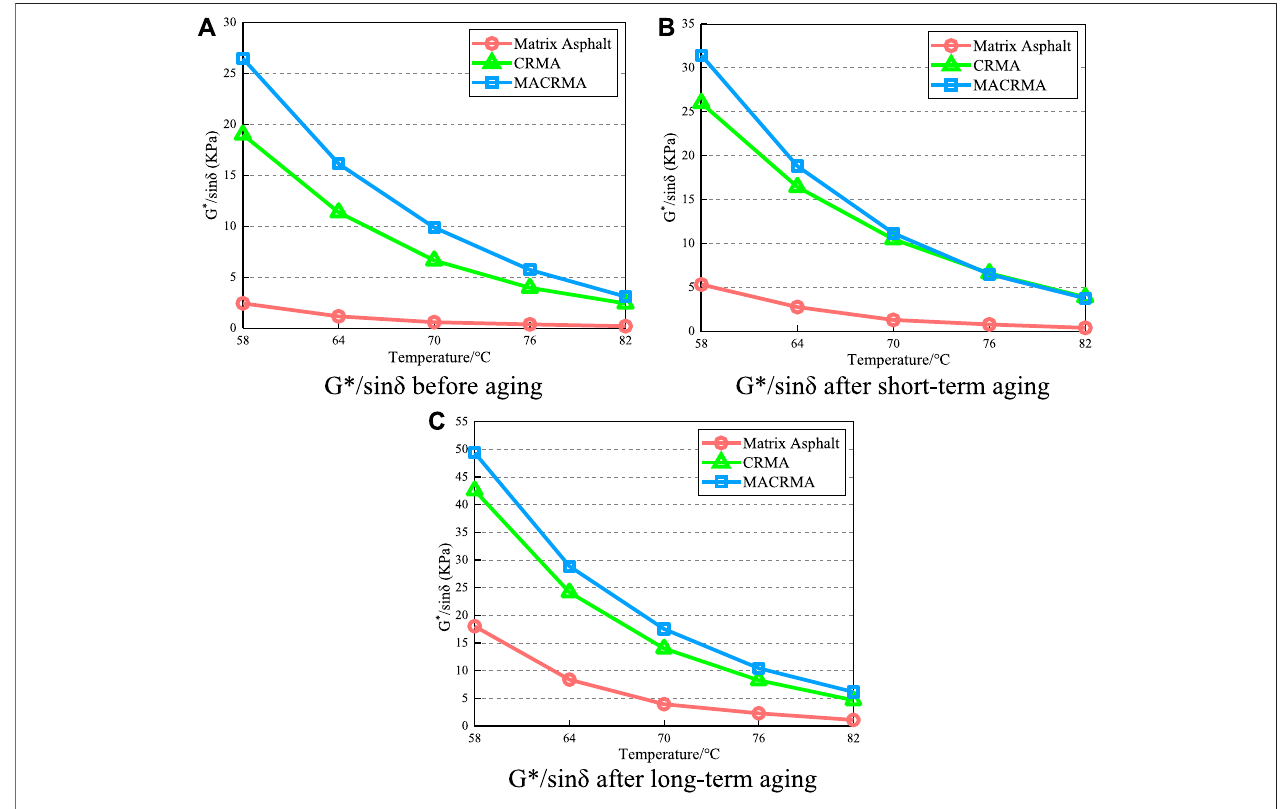
FIGURE 6 | The results of G*/sin δ . (A) G*/sin δ before aging, (B) G*/sin δ after short-term aging, (C) G*/sin δ after long-term aging.